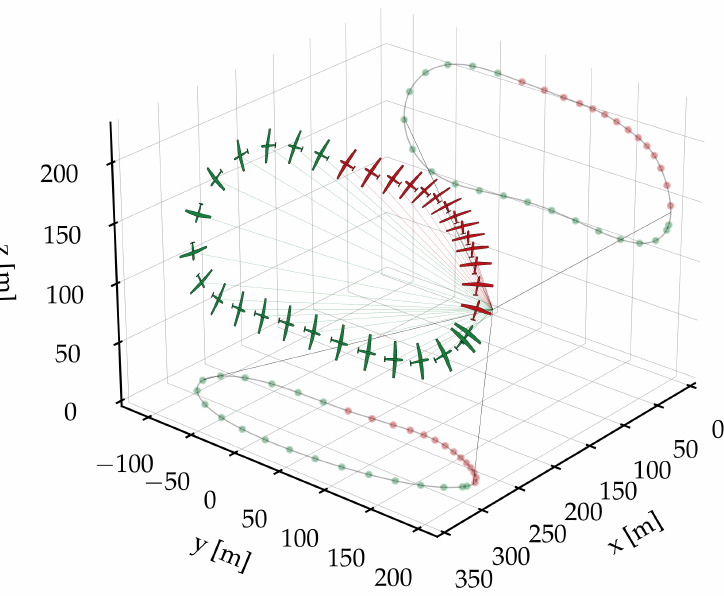
Figure 4. Locally optimal single-aircraft position and orientation trajectory nr. 1 (circular pattern) as found by User A. For better visibility, the aircraft are depicted at a scale 5:1. Green color signifies positive power output, red color negative power output.